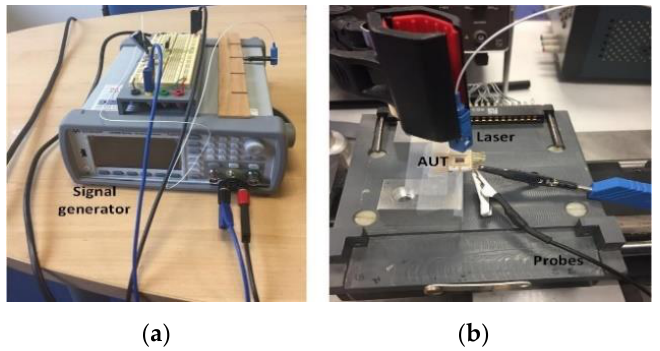
Figure 8. Experimental devices; ( a ) square signals generator; ( b ) testing nanoantenna with laser excitation.